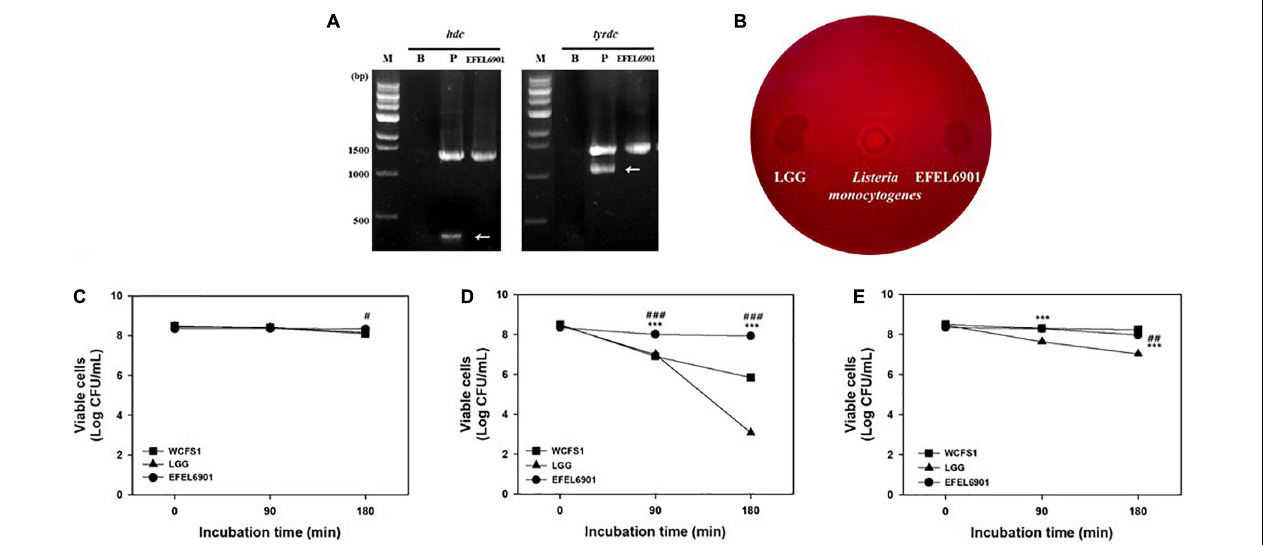
FIGURE 1 | Safety and stability assessment of Limosilactobacillus reuteri EFEL6901 strains. (A) Detection of genes related to biogenic amine production. Lane M, 1 kb DNA marker; lane 1, negative control which has no template DNA; lane 2, positive controls having hdc (histidine decarboxylase, 440 bp), and tyrdc (tyrosine decarboxylase, 1100 bp) genes from L. reuteri ATCC 23272 and Enterococcus faecalis KCCM 11729, respectively. (B) Hemolytic activity analysis of L. reuteri EFEL6901. Hemolytic activity was measured in BHI broth containing 7% horse blood. Left, the negative control, L. rhamnosus GG; center, positive control, Listeria monocytogenes ; right, the EFEL6901 strain, showing clear zone around the cell drop. (C) Viability of L. reuteri EFEL6901 at pH 3.0. (D) Viability of L. reuteri EFEL6901 at pH 2.5. (E) Viability of L. reuteri EFEL6901 in 0.3% bile salt. Significant differences are presented with L. plantarum WCFS1 ( # p < 0.05, ## p < 0.01, and ### p < 0.001) or L. rhamnosus GG (* p < 0.05, ** p < 0.01, and *** p <